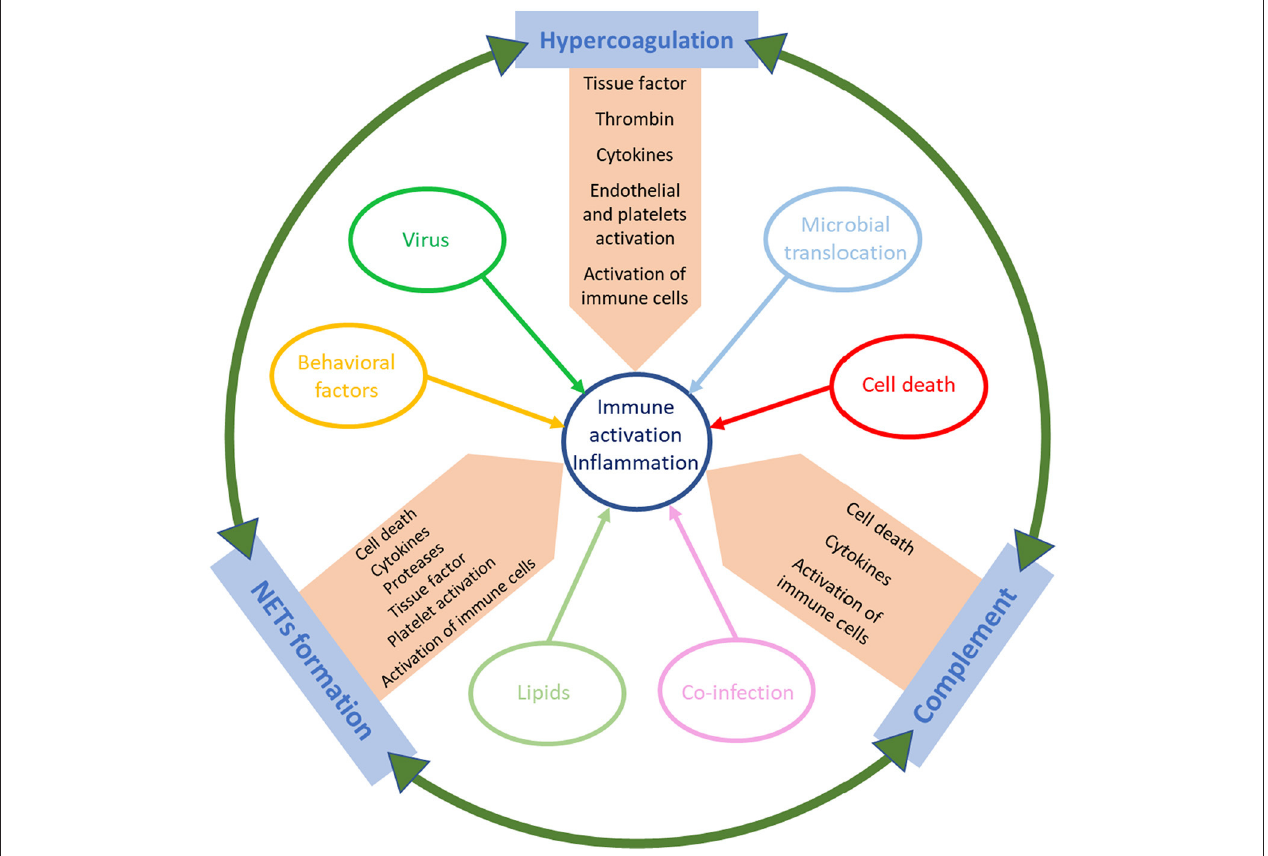
FIGURE 1 | Schematic representation of the factors that trigger immune activation and inflammation in HIV/SIV